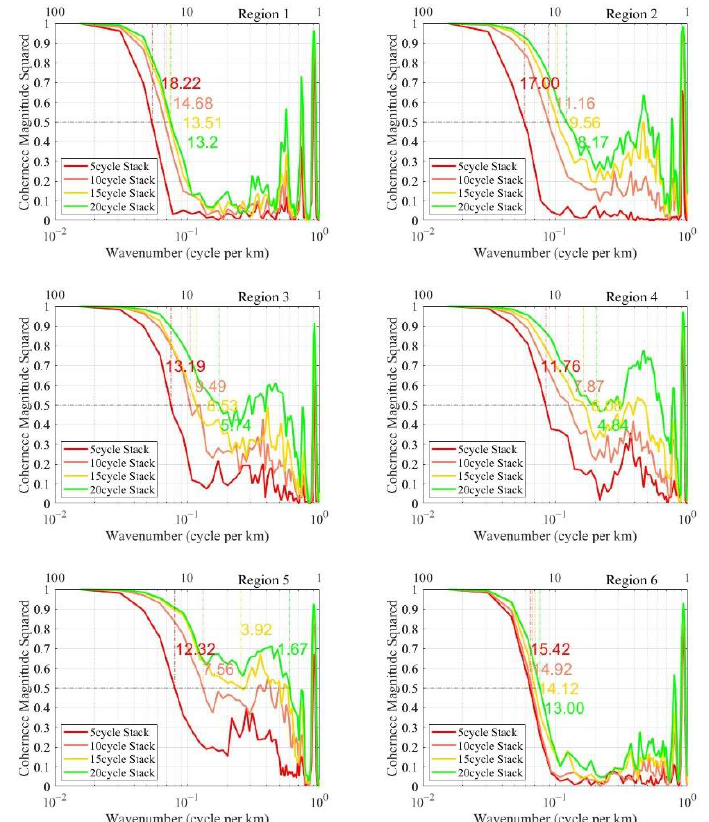
Figure 7. Coherence map and deduced resolution capabilities of HY-2B repeat track data sequences after stacking 5, 10, 15, 20 cycles’ data: Region 1, North Pacific; Region 2, South Pacific; Region 3, Mid-Pacific; Region 4, Indian Ocean; Region 5, North Atlantic; Region 6, South Atlantic.